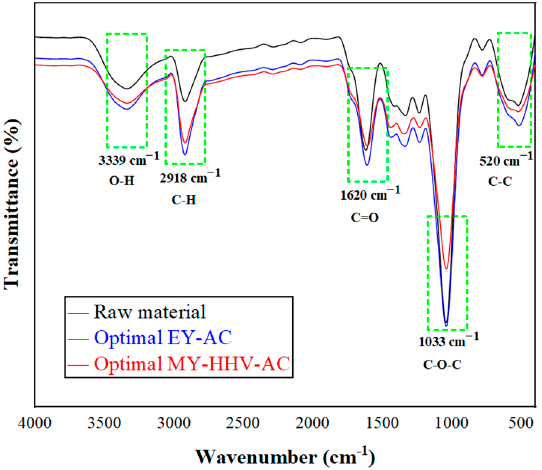
Figure 8. Fourier transform infrared spectra of raw material and the response sets after torrefac- tion.